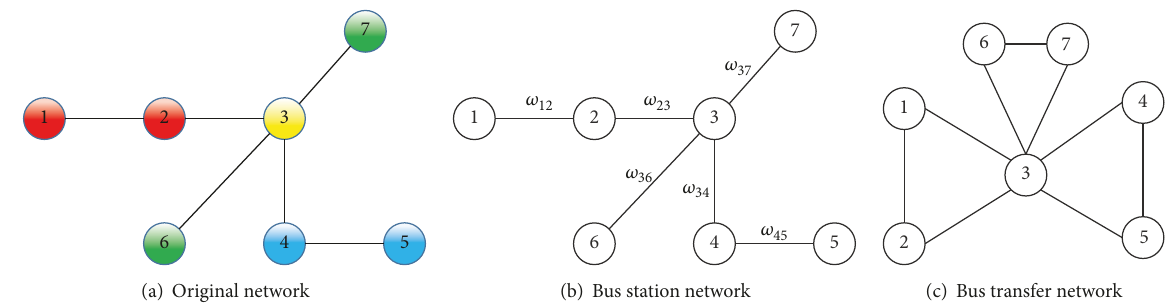
Figure 1: (a) An original network is composed of three bus routes. The three routes are displayed in red for route 1, blue for route 2, and green for route 3. Station 3, colored in yellow, is a common station shared by three routes. (b) The corresponding bus station network. The variables floating on the edges are, respectively, RBTT between any two stations which will be explained in the following sections. (c) The corresponding bus transfer network.